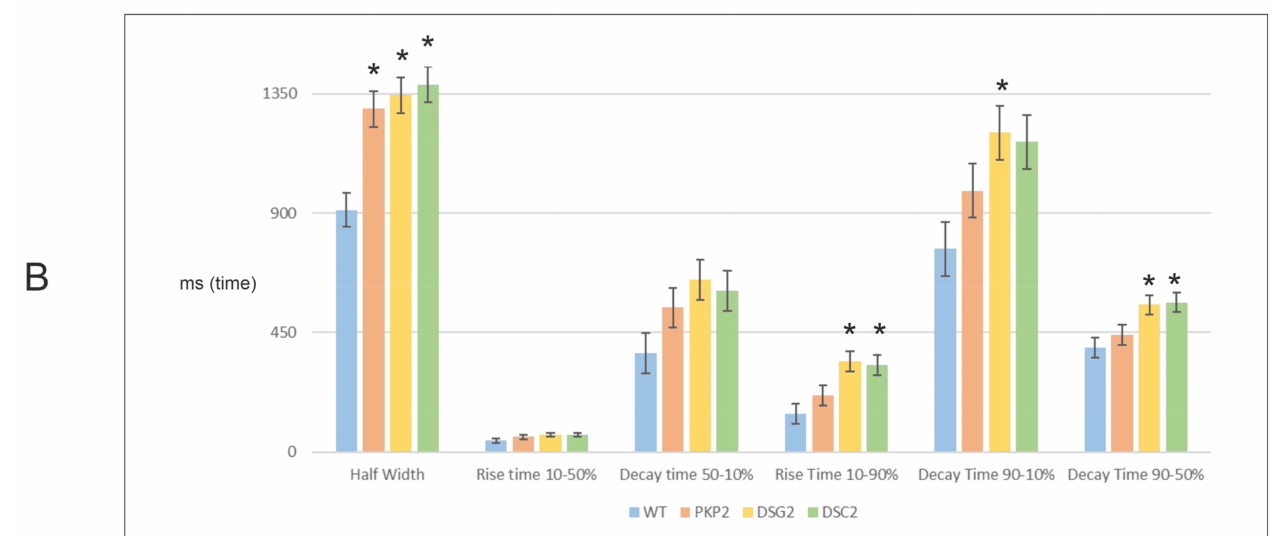
Figure 3. Calcium imaging peaks ( A ) and studied parameters ( B ) of the three KO groups: PKP2 -KO, DSG2 -KO, and DSC2 -KO. The black arrow in section A indicates the pulse of caffeine. * Indicates parameters that were significantly different compared with WT clones; p -value < 0.05, see Table